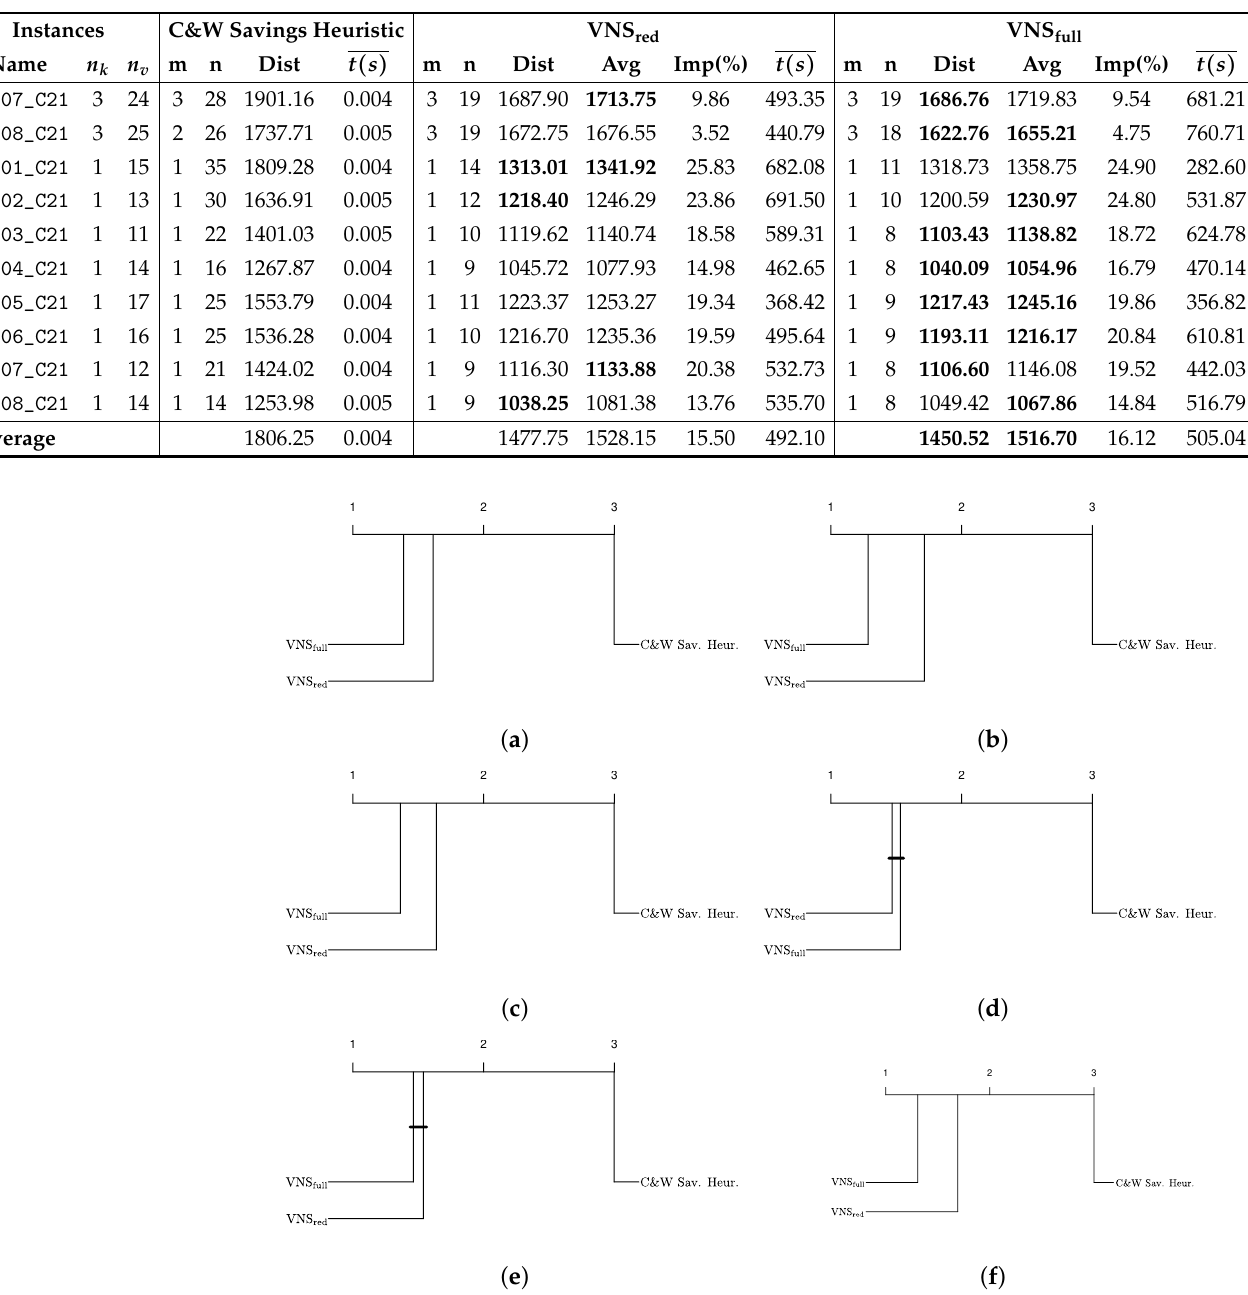
Figure 8. Critical difference plots concerning the results for large instances. The graphic in ( a ) con- siders all large instances, while the other graphics consider subsets of the set of large